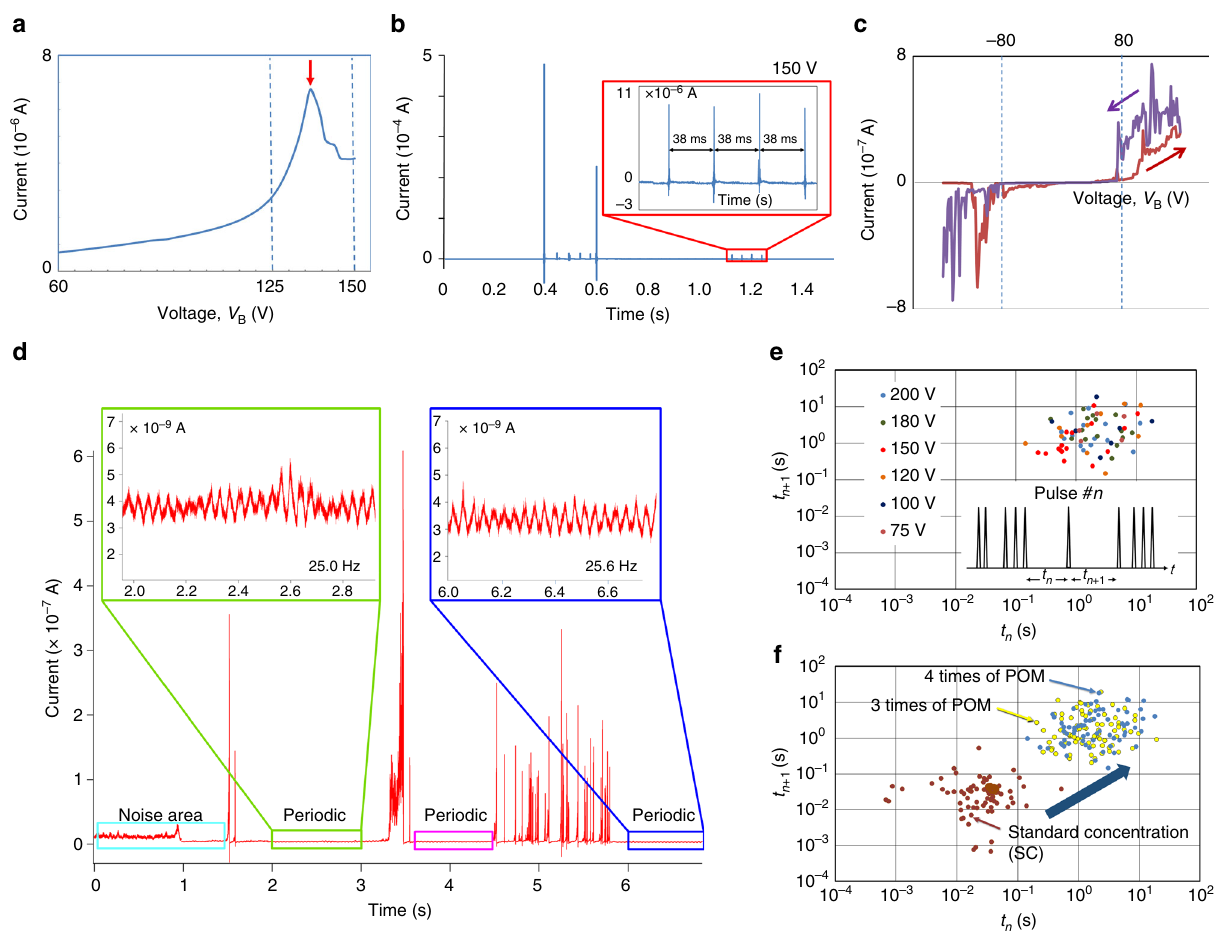
Fig. 3 Electrical characteristics of the SWNT/POM network. a I – V characteristics of sample A (rinsed with ethanol) lying between electrodes (1) and (2) in Fig. 2b. b Plot of the measured current versus time of sample A when V B was set at 150 V. (Inset) Magni fi cation of periodic current impulses. c I – V curve of the water-treated POM/SWNT samples (sample B). A number of NDR peaks are noticeable over approximately 80 V. d Time dependence of the current at 80 V. (Inset) Magni fi cation of periodic base current modulation. e Poincaré plots formed by changing the applied voltage obtained using sample A. (inset) ; (cid:1)(cid:1)(cid:1) ). f Dependence of ISIs for sample A on the concentration ratio of POM to Example of impulse trains and sequences of the ISIs ( (cid:1)(cid:1)(cid:1) ; t n ; t n þ 1